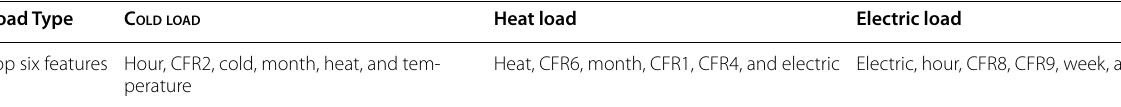
Table 4 Top six features affecting the cold, heat, and electric load forecasting Load Type C old load Top six features Hour, CFR2, cold, month, heat, and tem-